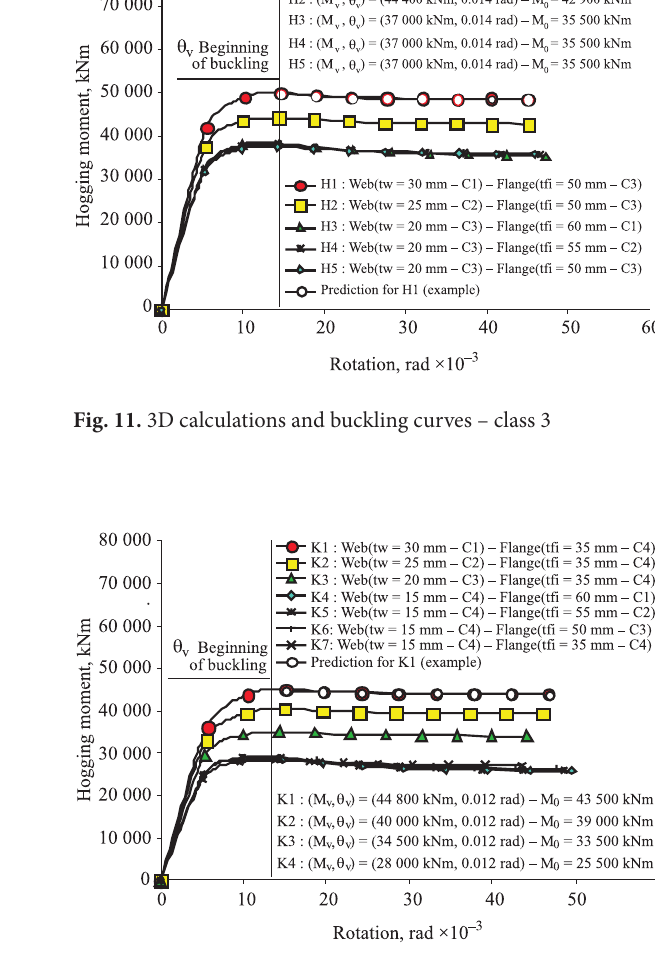
Fig. 10. Without springs (a); with springs (b)